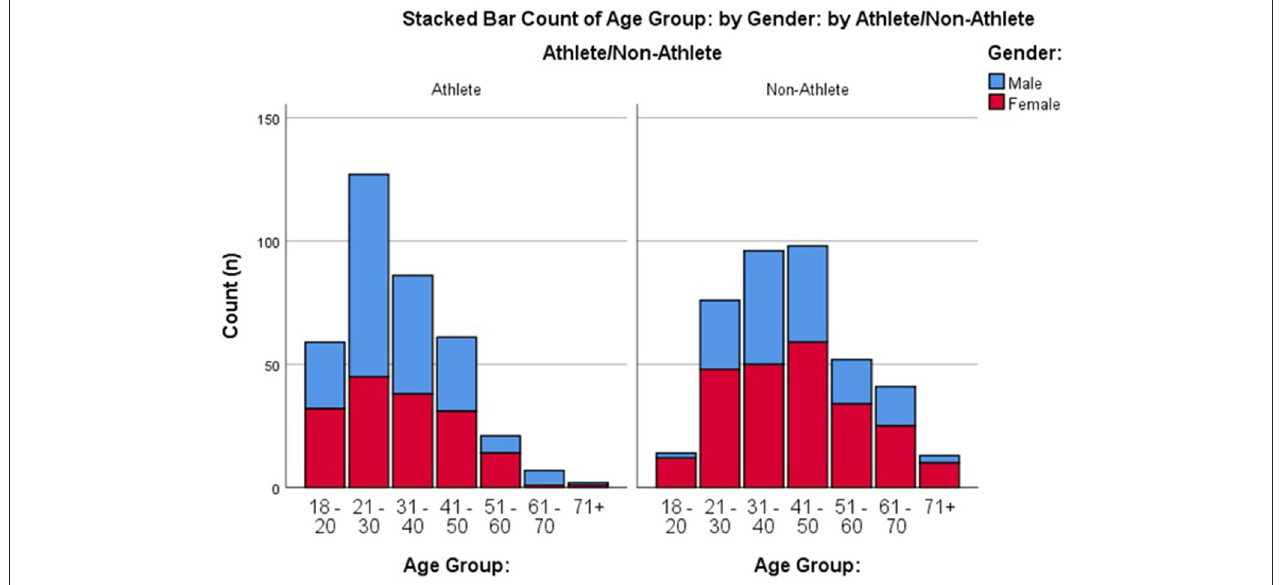
FIGURE 1 | Histogram detailing the gender split and age ranges for athlete and non-athlete groups.